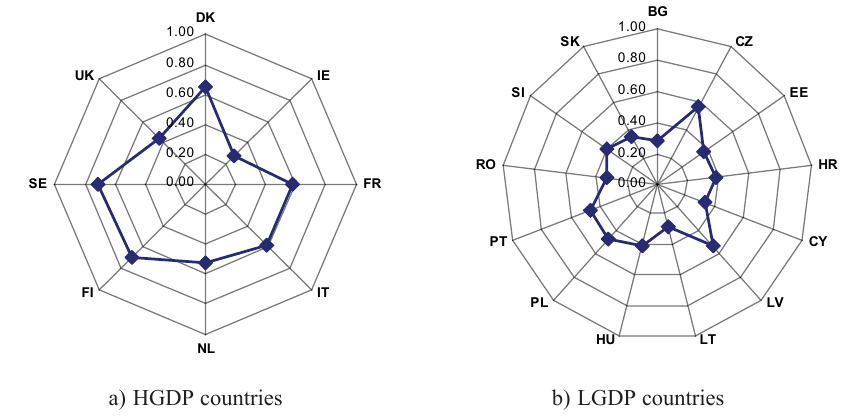
Fig. 1. Fiscal decentralization index in HGDP and LGDP